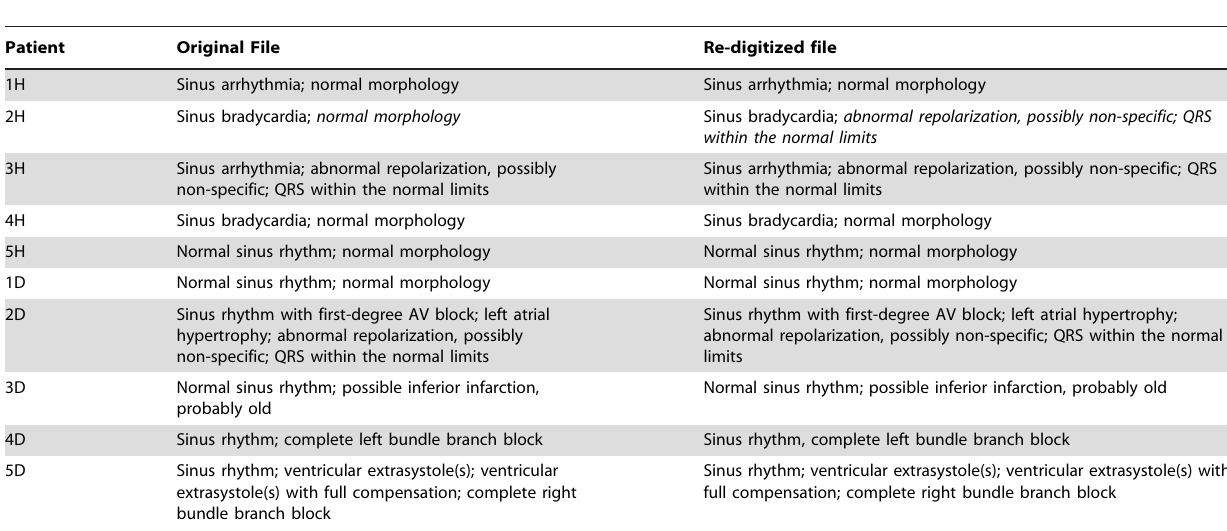
Table 4. Automated clinical diagnostic statement(s) outputted by the Leuven algorithm for the original vs. re-digitized files when the original file was collected on a Cardiax ADC and the re-digitized file on either a Cardiax or CorScience